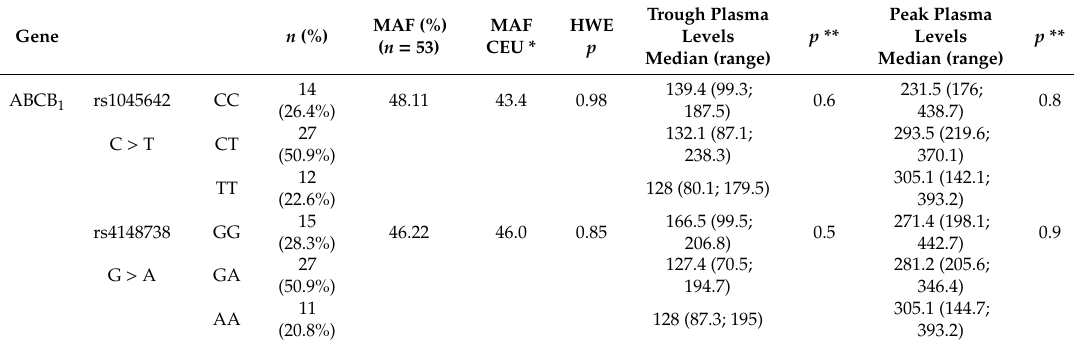
Table 2. Distribution of ABCB 1 genotype and allele frequencies.